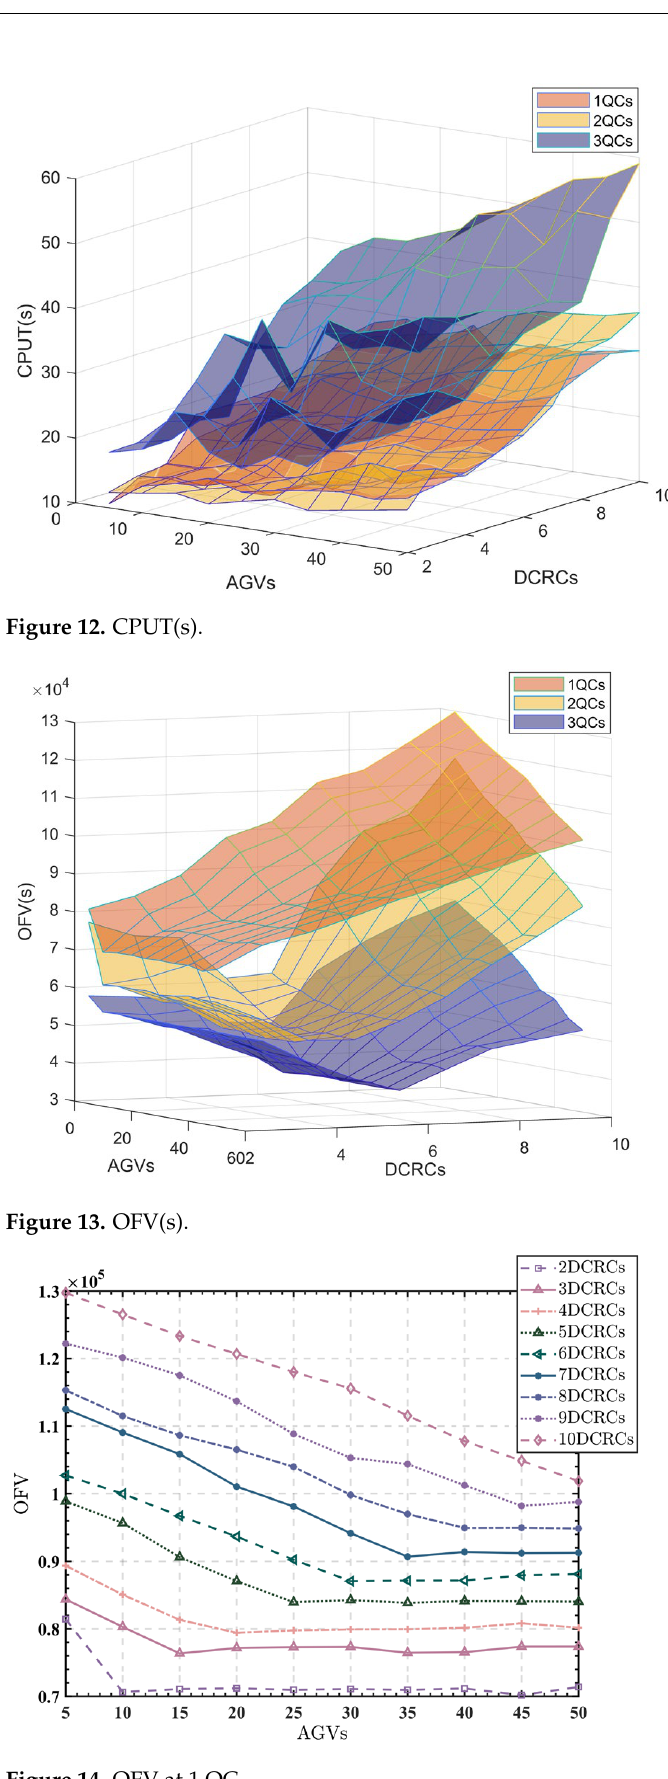
Figure 15. OFV at 2 QCs.